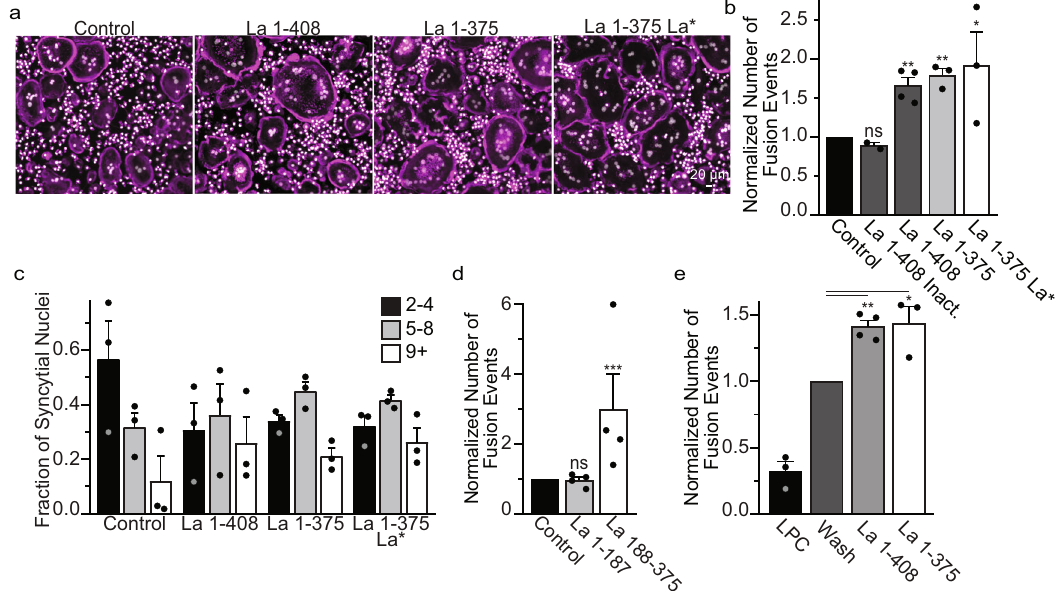
Fig. 4 | Recombinant La promotes osteoclast fusion. (a) Representative fl uor- escence images of human osteoclasts 3 days post RANKL addition without or with the overnight (end of day2 post RANKL) addition ofrecombinant heat-inactivated La 1-408, La 1-408, La 1-375 or La 1-375 Q20A/Y24A/D33I. Recombinant proteins were added at ~40nM at the end day 2 post-RANKL addition, and cells were fi xed the next morning. (Magenta = Phalloidin-Alexa488, Grey = Hoechst) (b) Quanti fi cation of a . (inactivated n=2; La 1-408 n=4, others n=3,) (P=0.1232, 0.0015,0.0035and0.0491,respectively) (c) Quanti fi cationofthefractionofnuclei in fused cells that were present in syncytia of various sizes from a . (n=3). (d) Quanti fi cationofthenumberoffusioneventswithorwithouttheadditionofLa